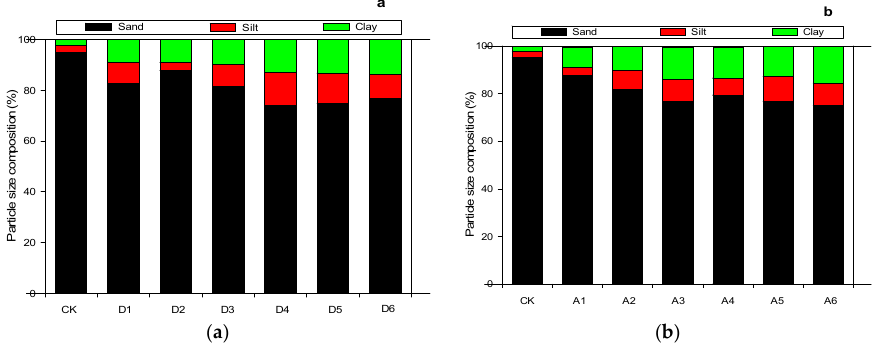
Figure 9. Relationship between poplar density, age, and soil particulate size composition: ( a ) particulate size composition of soil in the six experiment sites with different densities and the control site; ( b ) particulate size composition of soil in the six experiment sites with different ages and the control site.